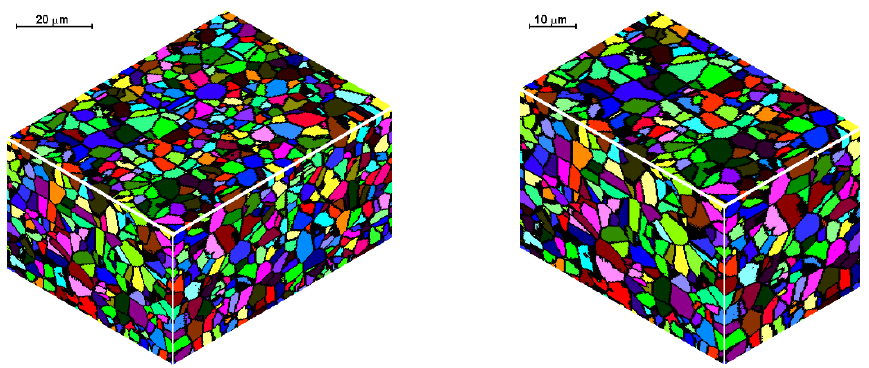
Figure 10. Reorganization of space by cutting in one direction.